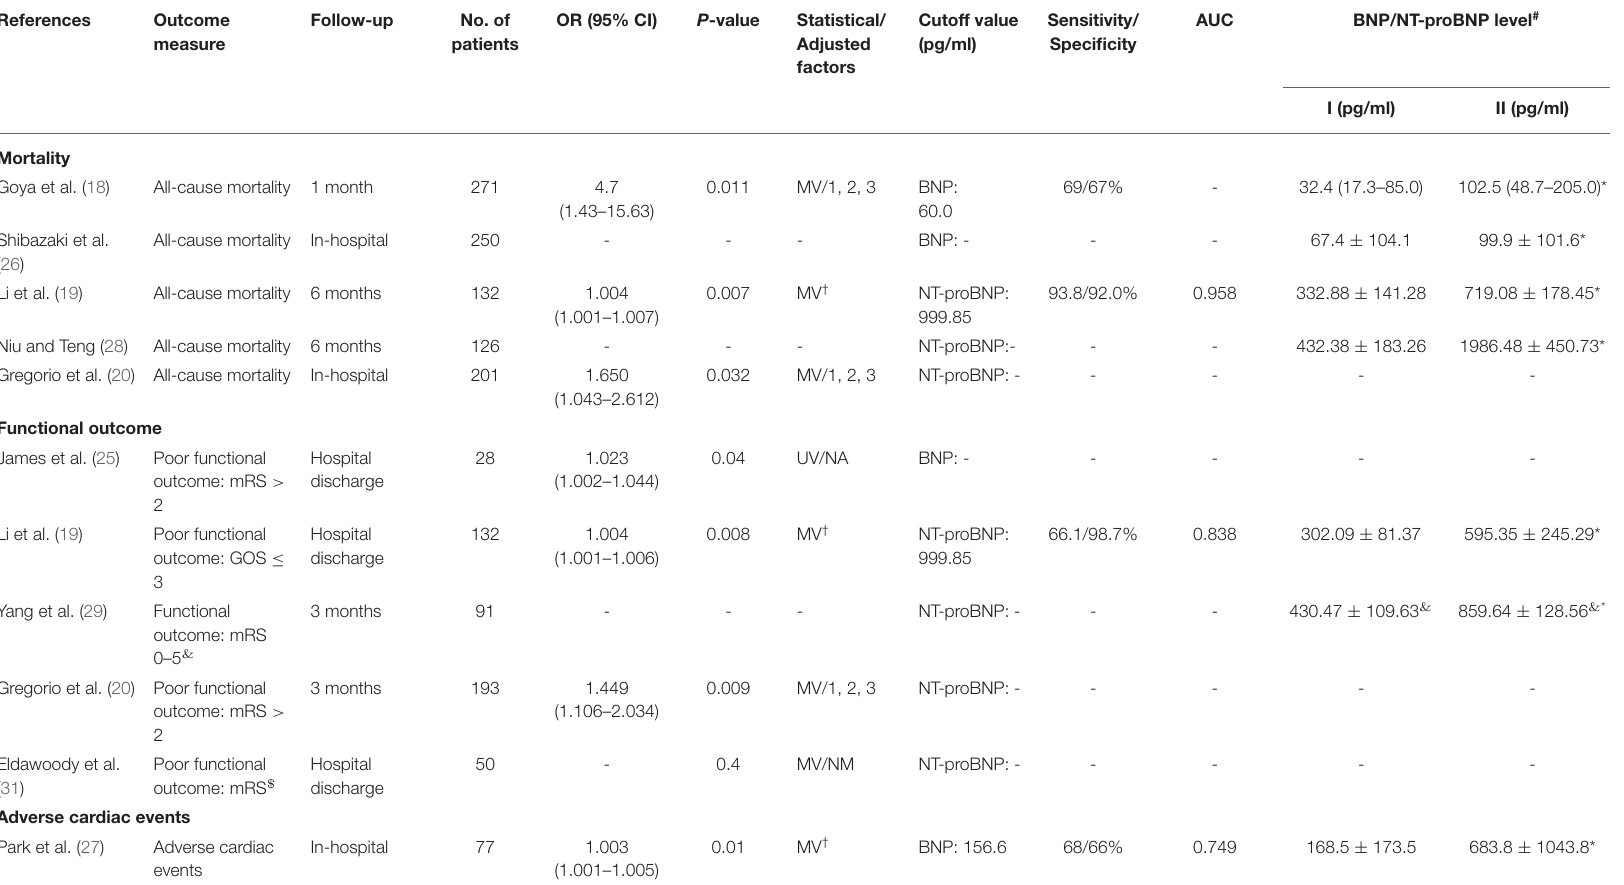
TABLE 2 | The association between BNP/NT-proBNP levels and prognosis of